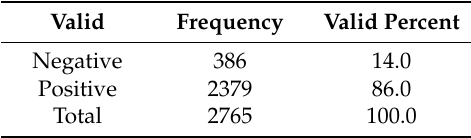
Table 5. Distribution of Rhesus (Rh) groups.